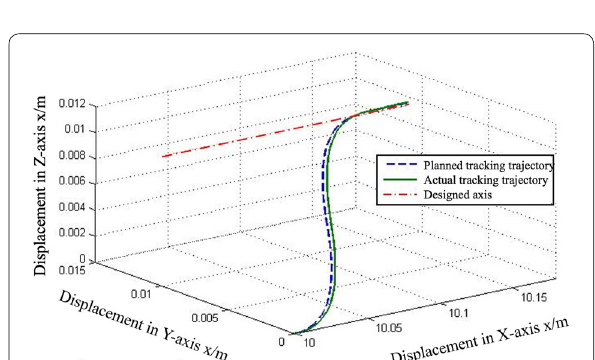
Figure 12 Tracking trajectory when deviation in both Y -axis and Z -axis